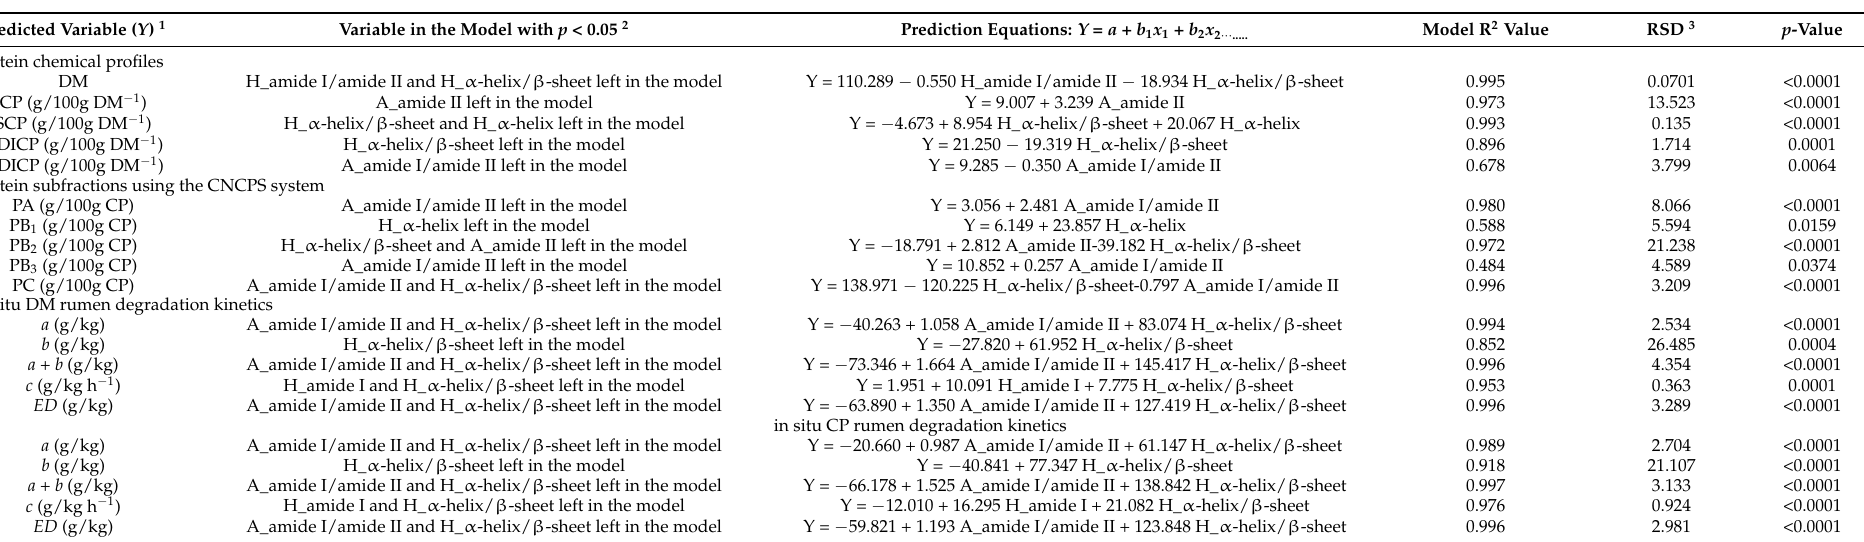
Table 5. Regression analysis to find the most important variables to predict nutrient supply using protein molecular spectral parameters in different byproducts of seed-used